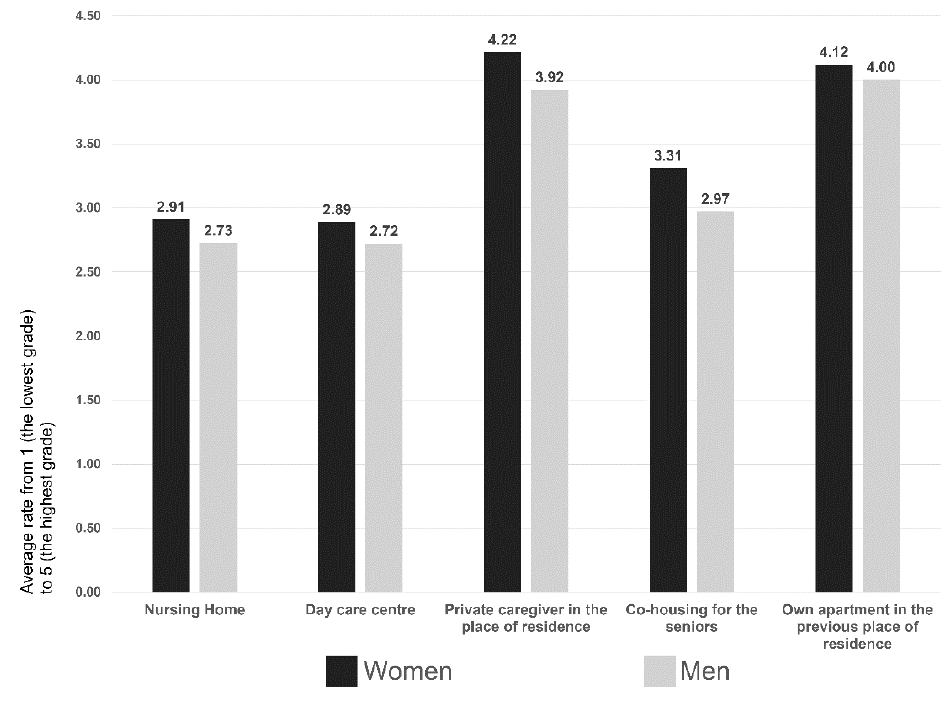
Figure 4. Average rate of the relevant forms of housing for the elderly depending on gender.